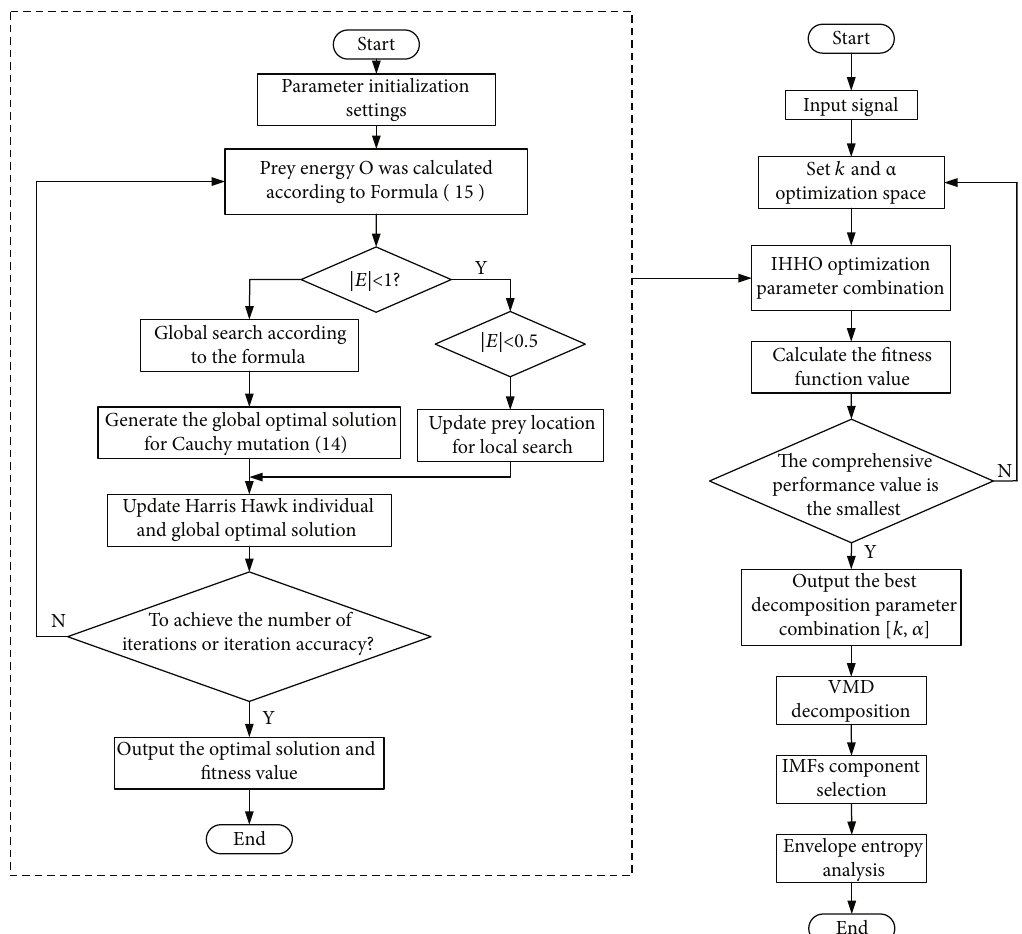
Figure 3: IHHO-VMD fl ow chart.